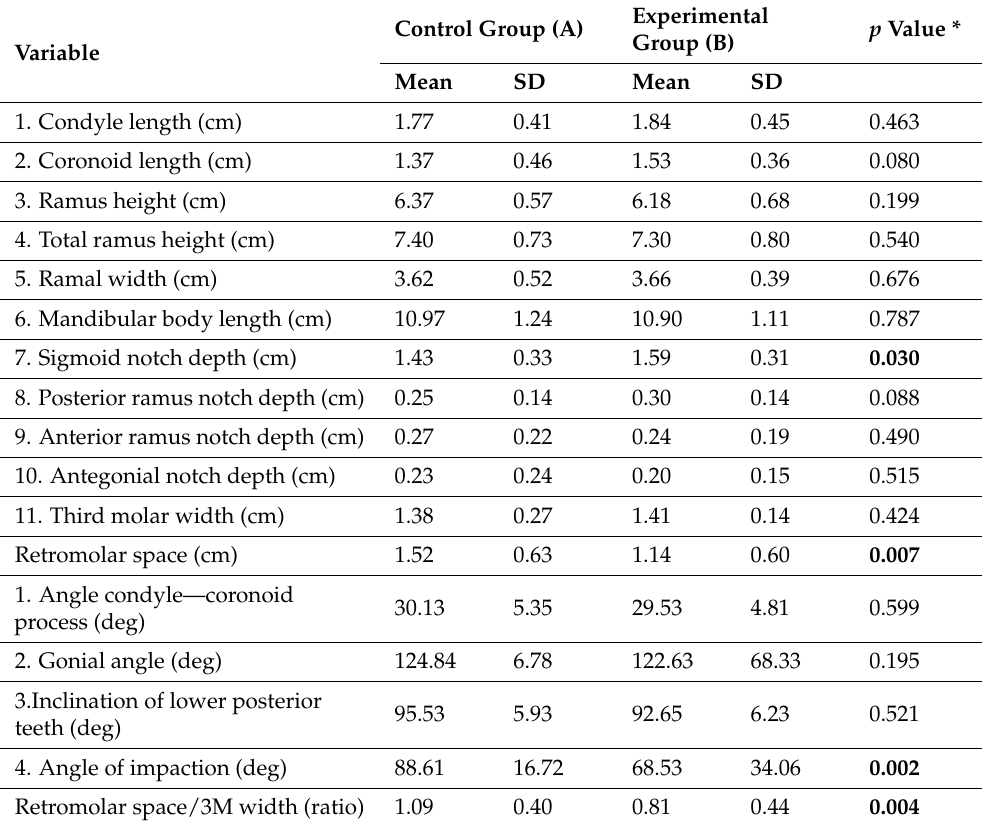
Table 1. Reference points: 13 variables (8 linear, 4 angular and 1 ratio) determined and measured.